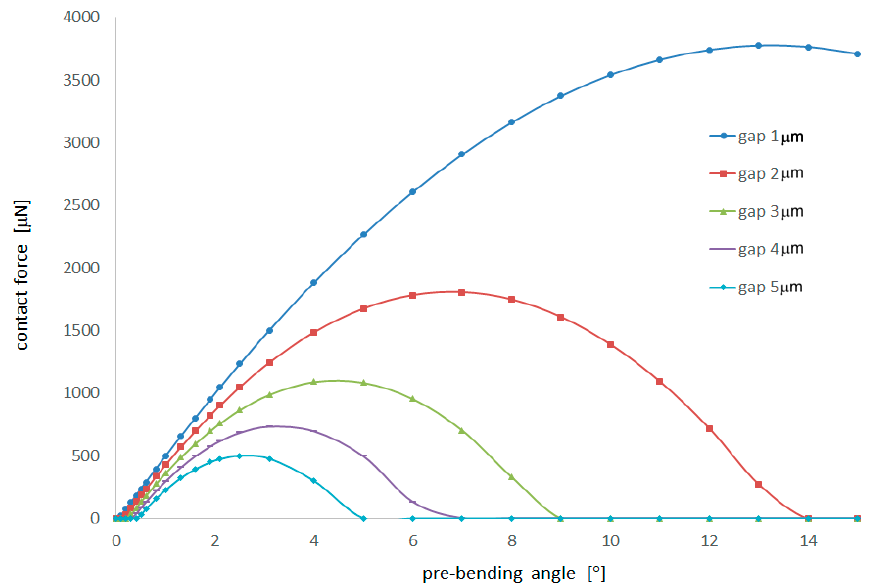
Figure 7. Pre-bending angle–contact force characteristics of the V-type actuator with straight